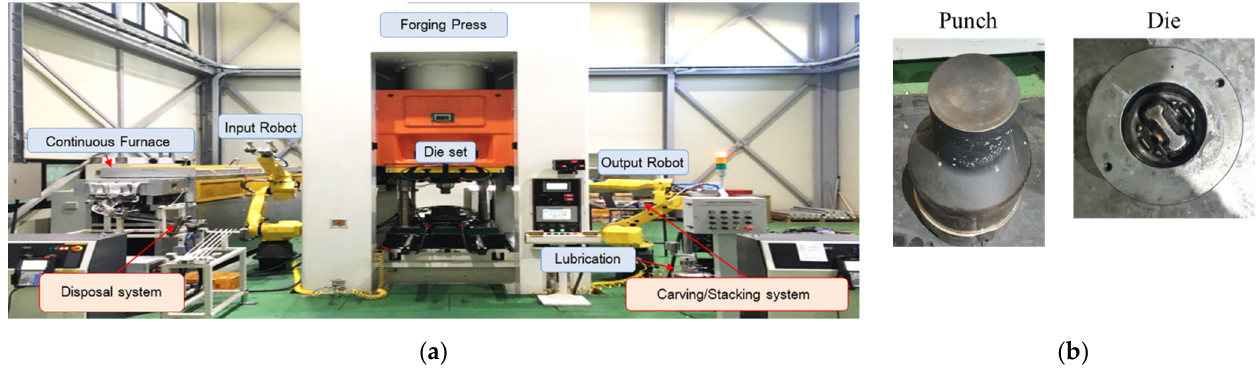
Figure 20. ( a ) Experimental set-up and ( b ) punch and die utilized in the verification experiments.